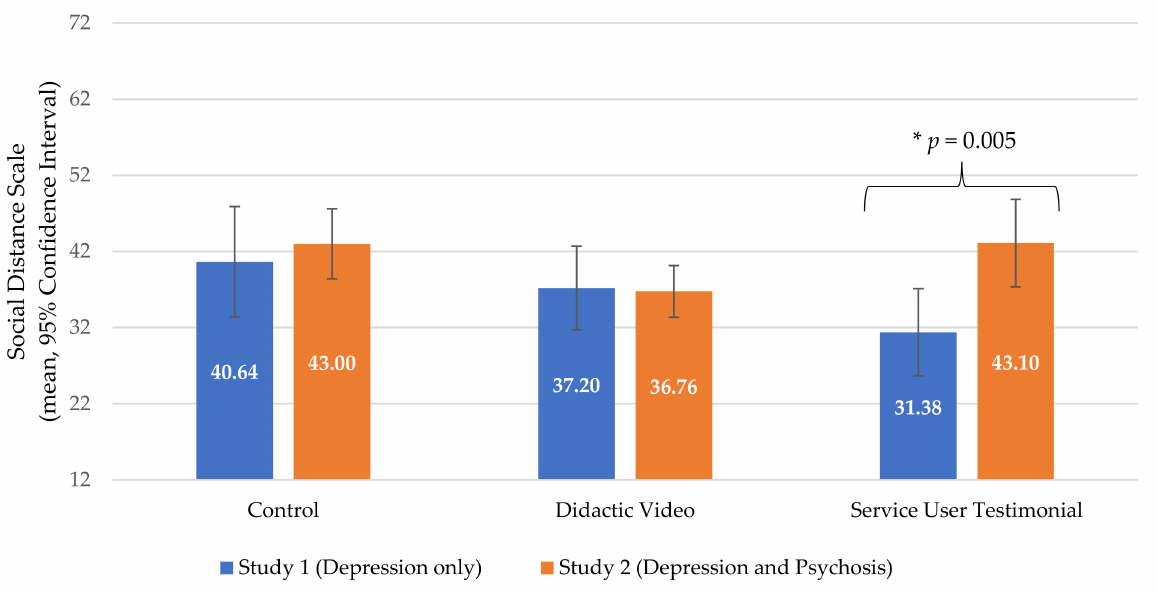
Figure 4. Social distance towards mental illness among second-year medical students at Tribhuvan University in Study 1 (depression only, n = 45) vs. second-year medical students at Tribhuvan University in Study 2 (depression and psychosis, n =